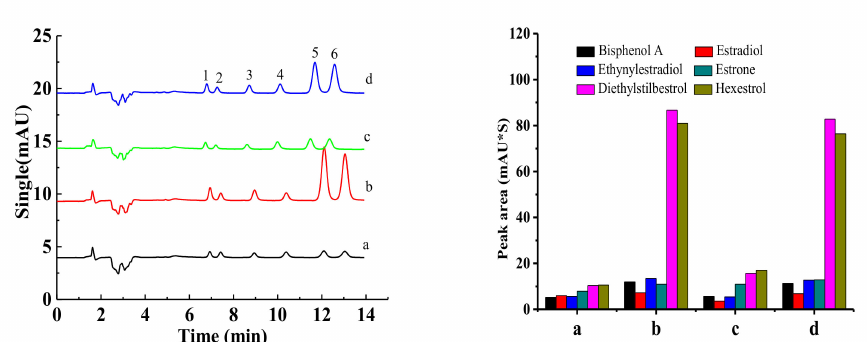
Figure 6. Chromatograms of the target compounds using four kinds of fibers with different surface wettabilities ( Left ) and the comparative peak area for each target compound using 4 kinds of wires for in-tube SPME ( Right ). Symbol identification: (a) pristine wire, (b) superhydrophilic wire, (c) su- perhydrophobic wire, (d) superhydrophilic wire after UV irradiation. Conditions: sampling volume, 60 mL; sampling rate, 2.00 mL/min; desorption time, 2.0 min. Peak identification: (1) bisphenol